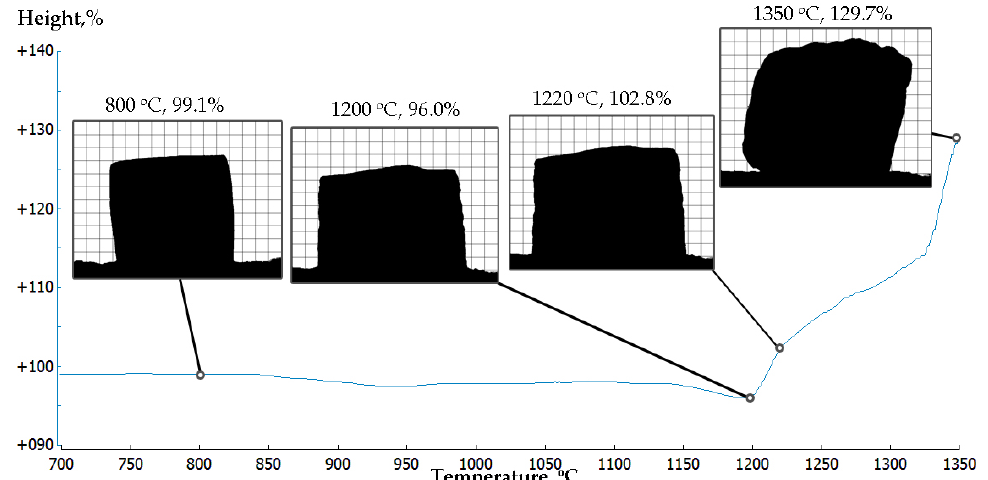
Figure 2. Hot stage experiment presents the changes in height of the specimens in the range of 700– 1350